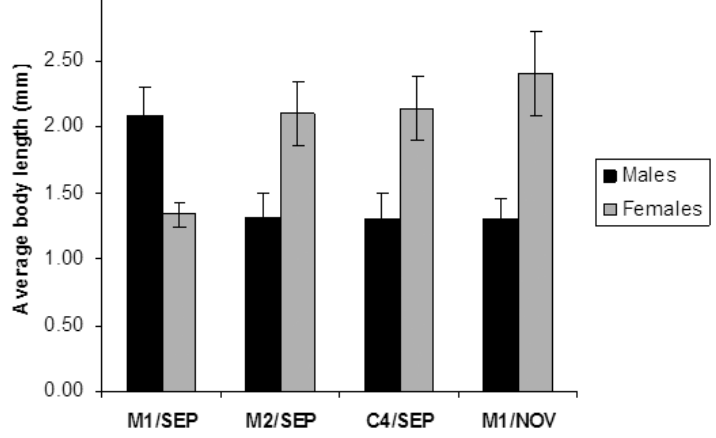
Fig. 4 – Average male and female body length variations (mean ± SD) in the different monthsandsamplingstationsintheCuruçáRiverestuary(CuruçáCounty,AmazonRegion).